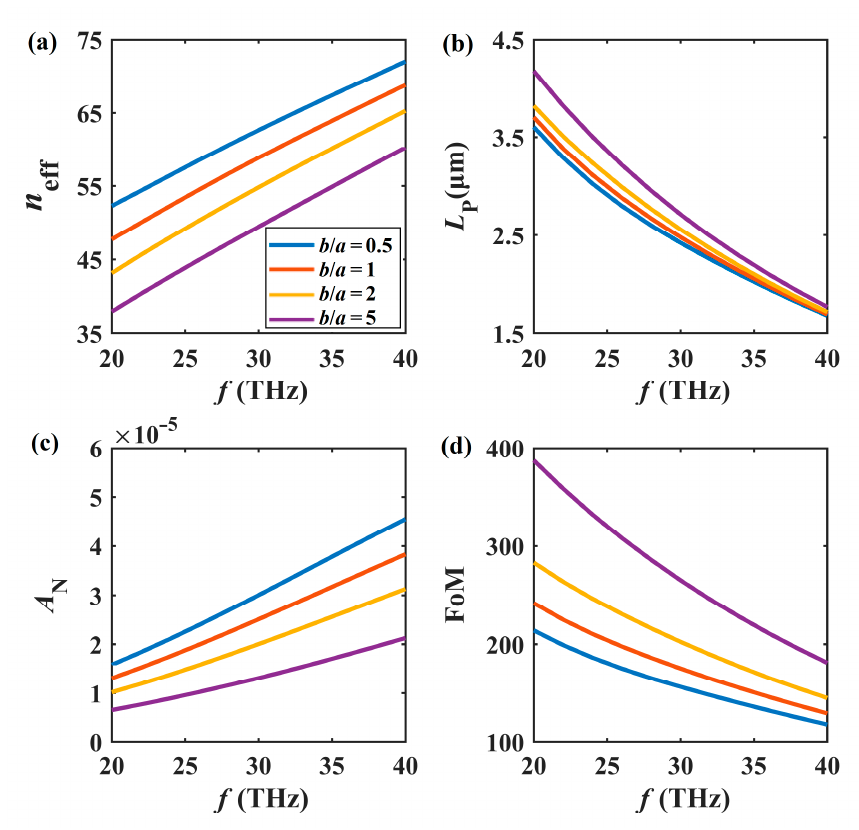
Figure 5. Modal properties of f at different b / a values. ( a ) n eff , ( b ) L P , ( c ) A N , ( d ) FoM.